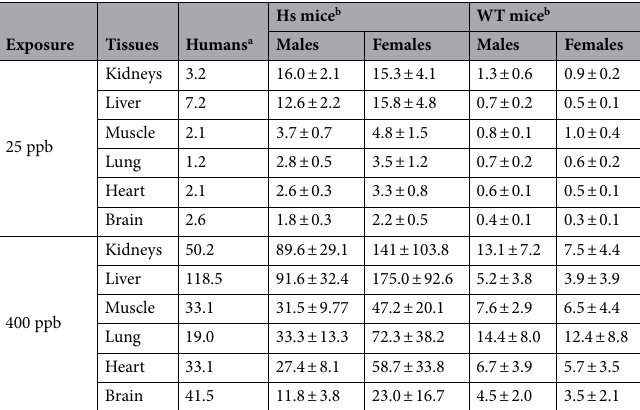
Table 1. Tissue total As concentrations (µg/kg) for humans and male and female Hs and WT mice exposed to 25- or 400-ppb (µg As/L) in drinking water for 14 days. a Estimated steady state tAs levels calculated using the human PBPK model for iAs based on consumption of 2 L of iAs-contaminated drinking water per day. b tAs levels in mouse tissues determined in present study (Mean ± SD, N =